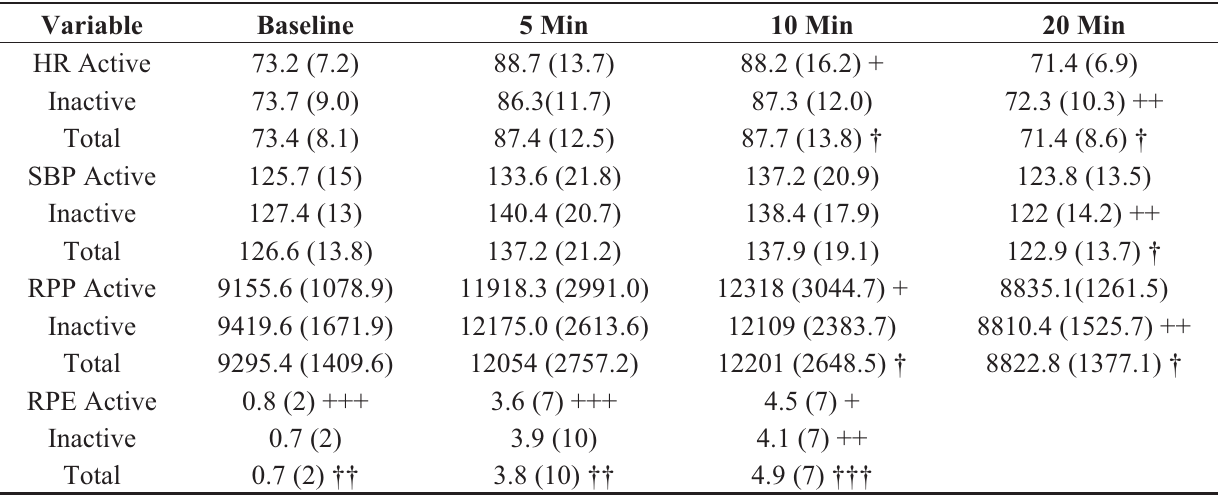
Table 3. Cardiovascular Response Outcomes N = 34 M